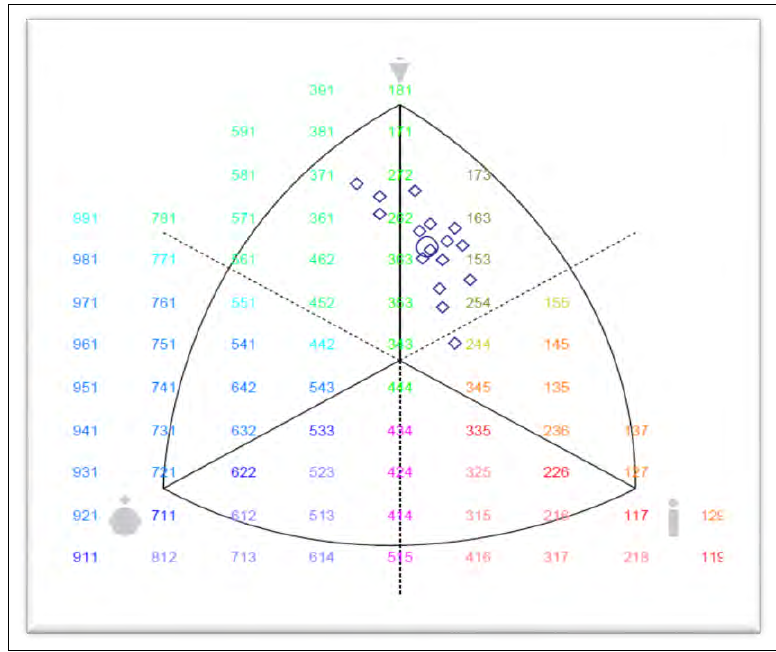
Figure 1. Somatotype features of young elite wrestlers. O = somatotype mean (2.16 – 5.9 –